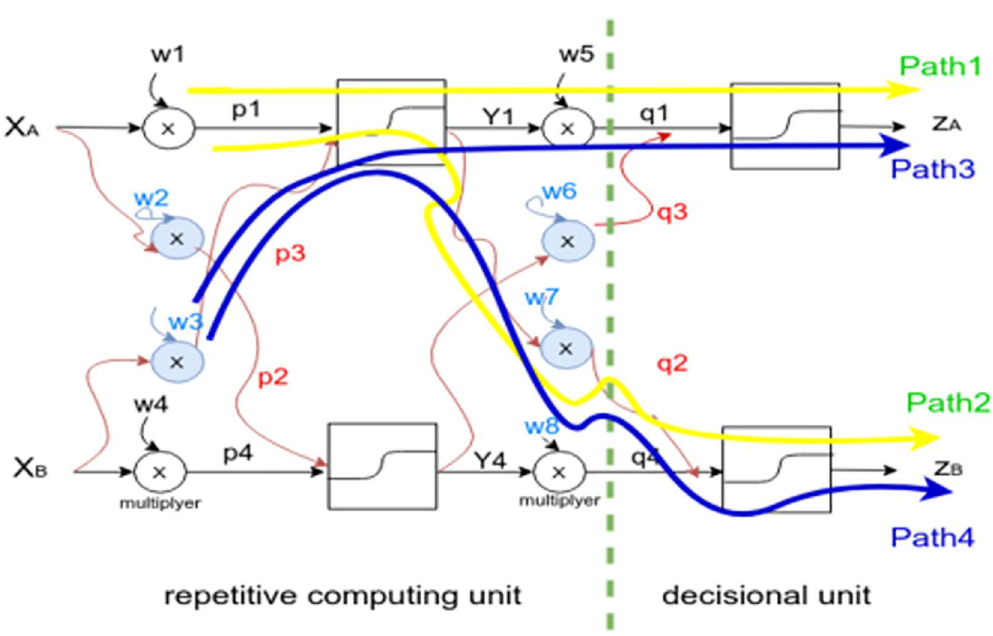
Fig 13. The proposed mode for